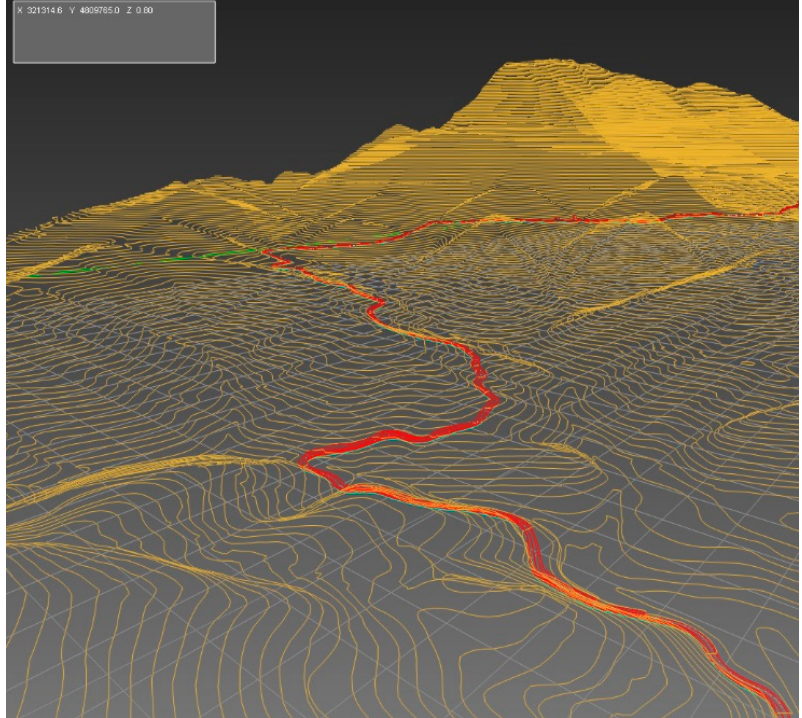
Figure 4. 3D characterization of the track. The road centerline (red) is shown in a Geographic Information System using a digital model (yellow) of the study area and road.